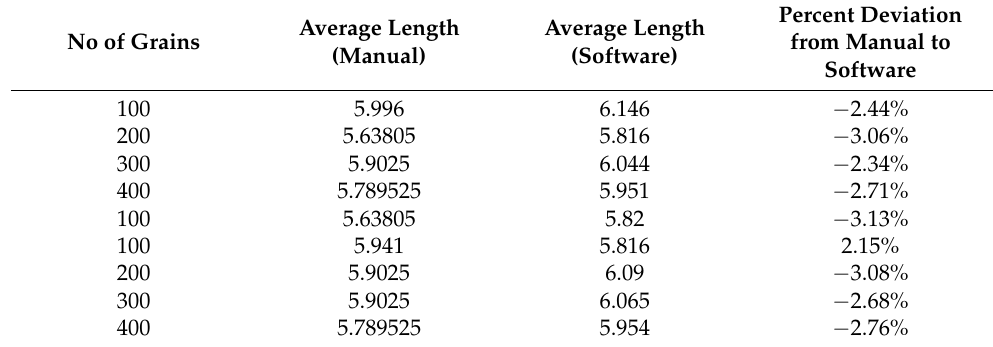
Table 2. Comparison between manual- and software-measured AGL results.